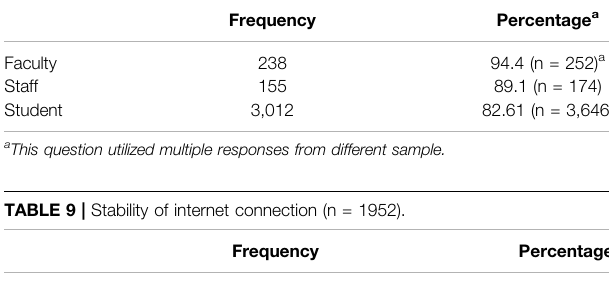
TABLE 5 | Students learning environment.